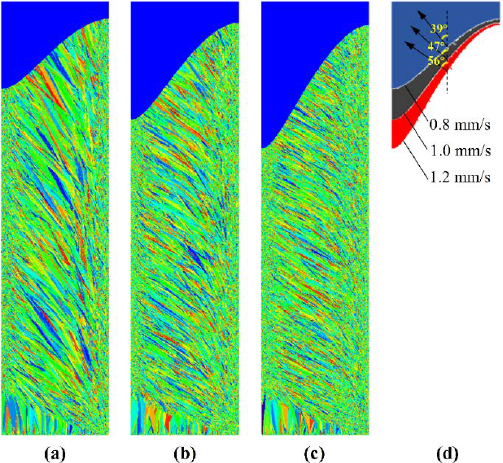
Figure 8. Grain structures predicted in the non-grain-refined billet with different casting speeds of ( a ) 0.8 mm/s (case 3), ( b ) 1.0 mm/s (case 2), and ( c ) 1.2 mm/s (case 4), accompanied with ( d ) the growth front profiles when the maximum height is reached.